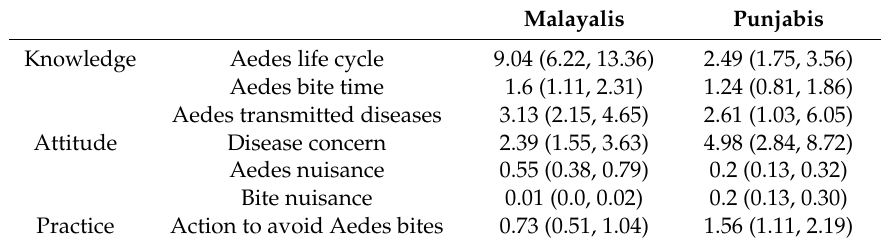
Table 2. Multivariate odds ratios (ORs) (95% confidence interval) of KAP compared to the Italian group. Model adjusted for age, sex and education level.